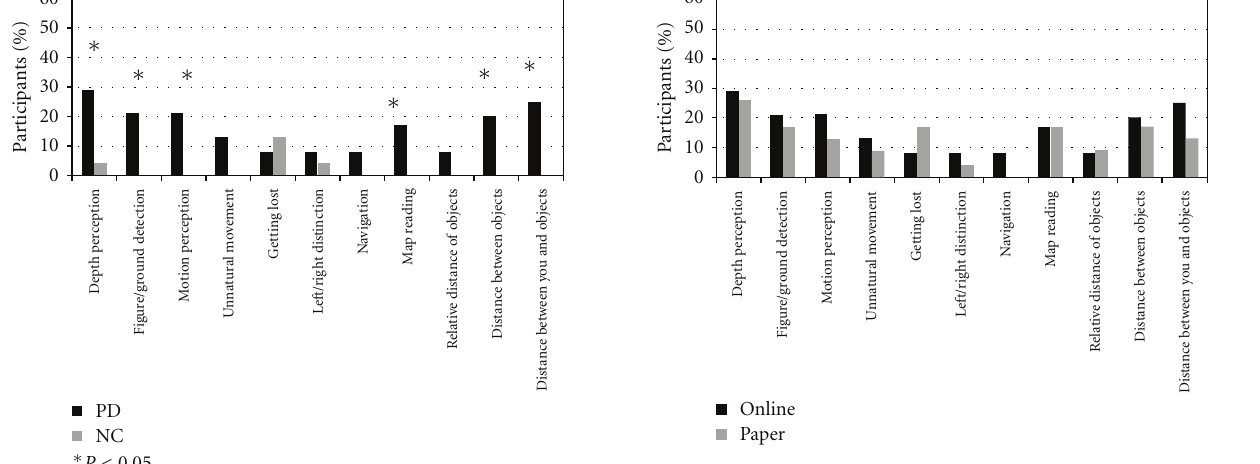
Figure 2: Percentage of PD participants reporting impairment on the visual and visuospatial items from the web-based versus paper- based questionnaires. There were no significant di ff erences in item responding for the two formats (all P (cid:2) s > 0 .